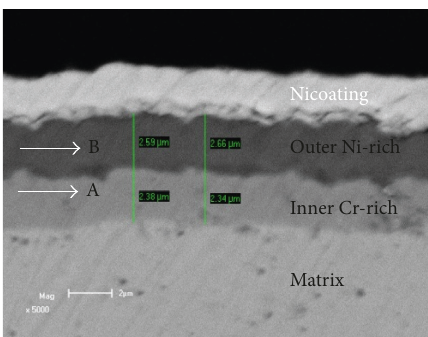
Figure 6: Back-scattered electron image of the cross section of the oxide film formed on C-276 in SCW for 500h.